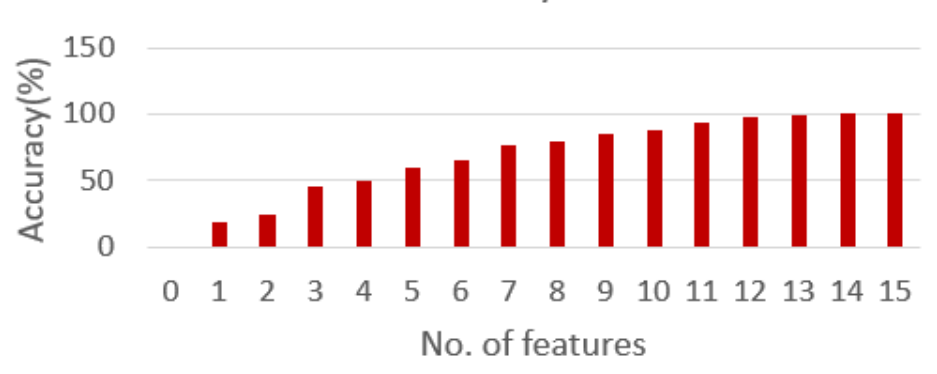
Figure 4. Cumulative accuracy vs. no. of features.